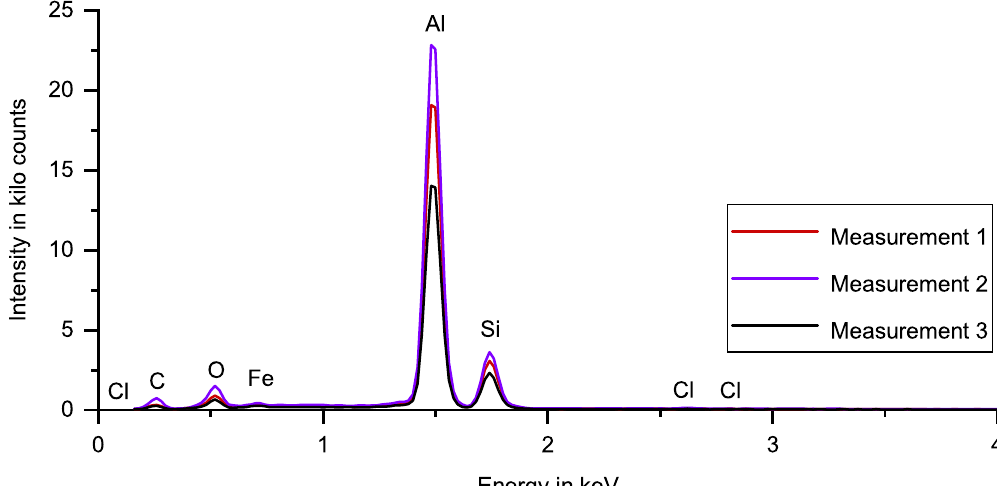
Figure 11. Three spectra for the AS-sample, superimposed in a single diagram. Aluminum, silicon, carbon, oxygen, iron and chlorine were detected. The three spectra differ in peak height, the peak positions do not change. One of the three spectra shows a weak chlorine signal with all peaks < 150